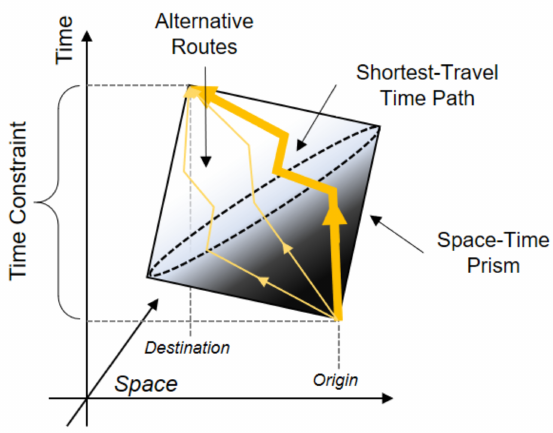
Figure 11. An example of a space-time